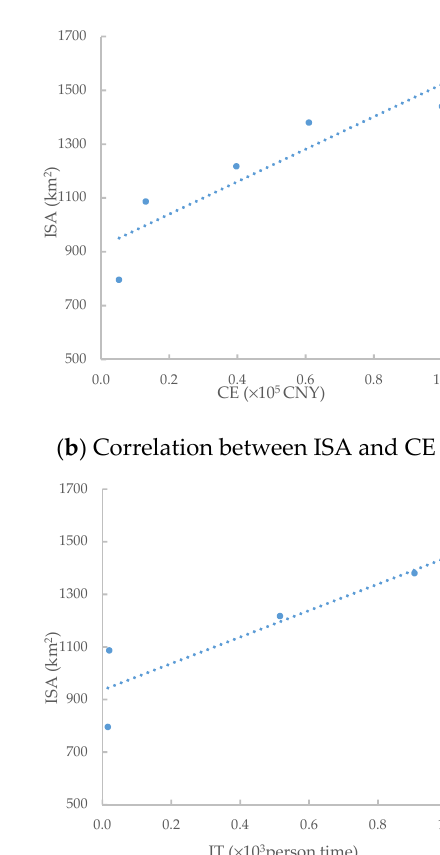
18 of 23 Figure 11. Correlation between ISA and socioeconomic indicators. Table 7. Dongying cultural indicators from 1995 to 2018. Indicators YEP (×10 5 )